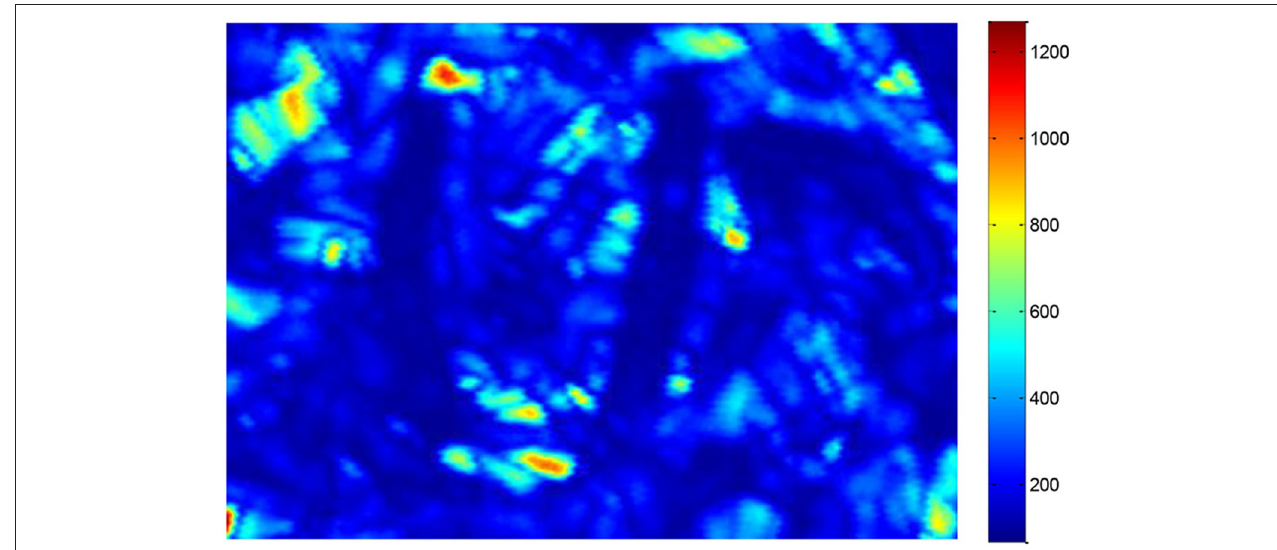
FIGURE 7 | False color image obtained by THz reflection imaging (2,480 × 3,509 pixels) with grayscale values varying from minimum and maximum values (68-1272).